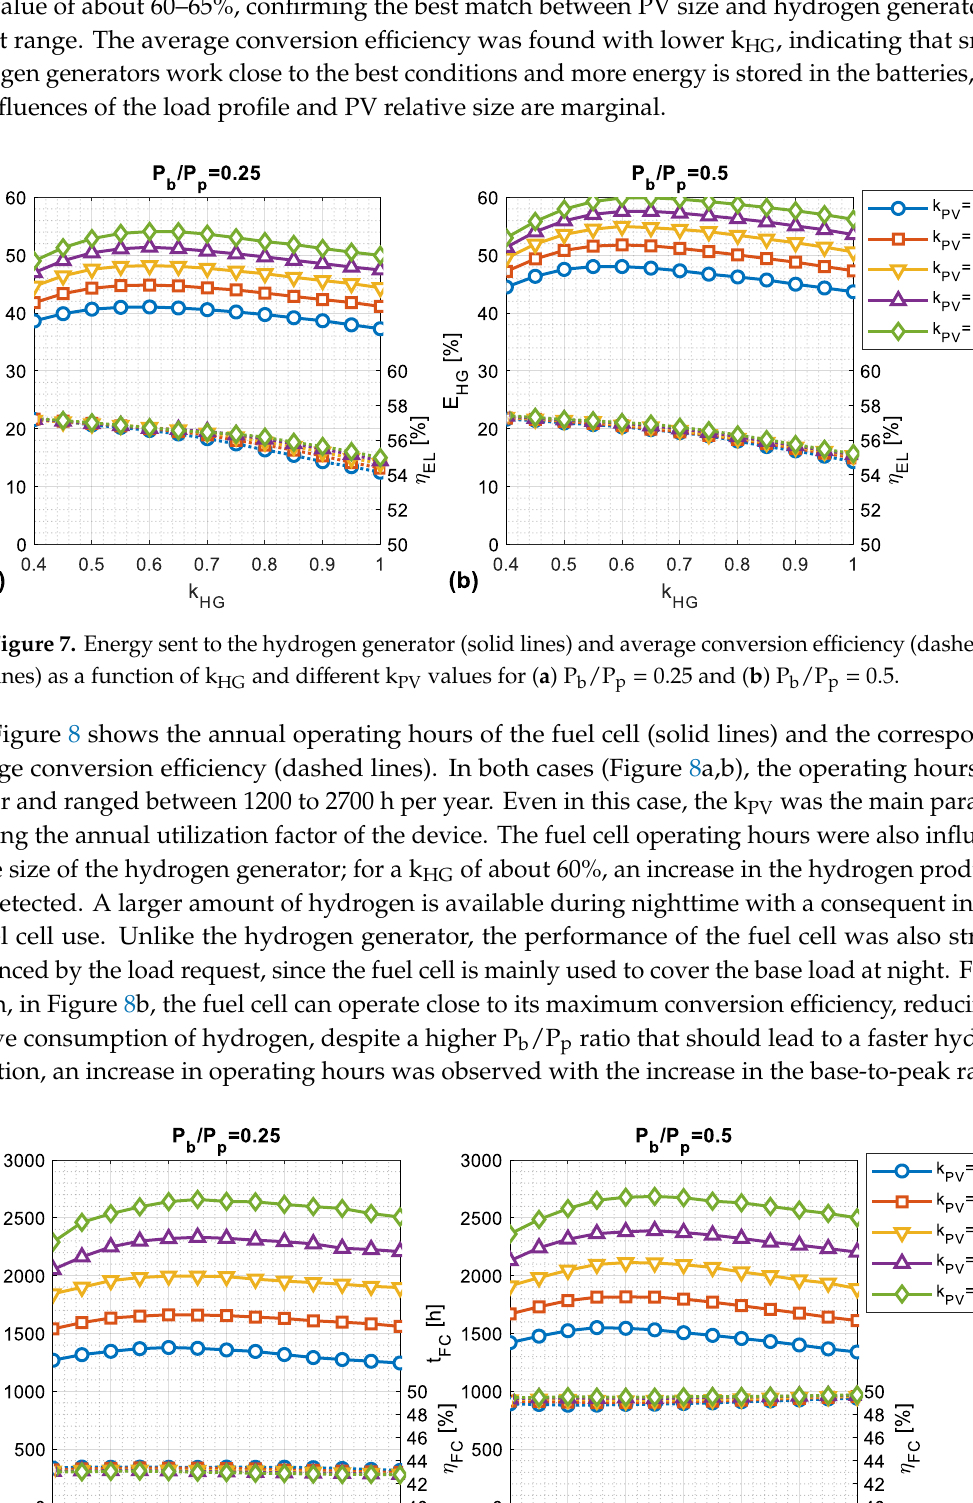
Figure 8. Numbers of hours in which the fuel cell is turned on during the year (solid lines) and related efficiency (dashed line) as a function of k HG and different k PV values for ( a ) P b /P p = 0.25 and ( b ) efficiency(dashedline)asafunctionofk HG anddifferentk PV valuesfor( a )P b /P p = 0.25and( b )P b /P p = P b /P p = 0.5.